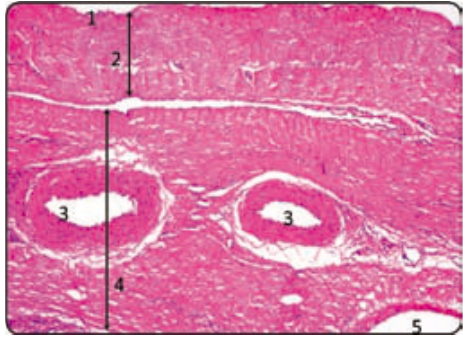
Fig. 6. Cross section of testicular capsule with visceral layer of tunica vaginalis. H&E x